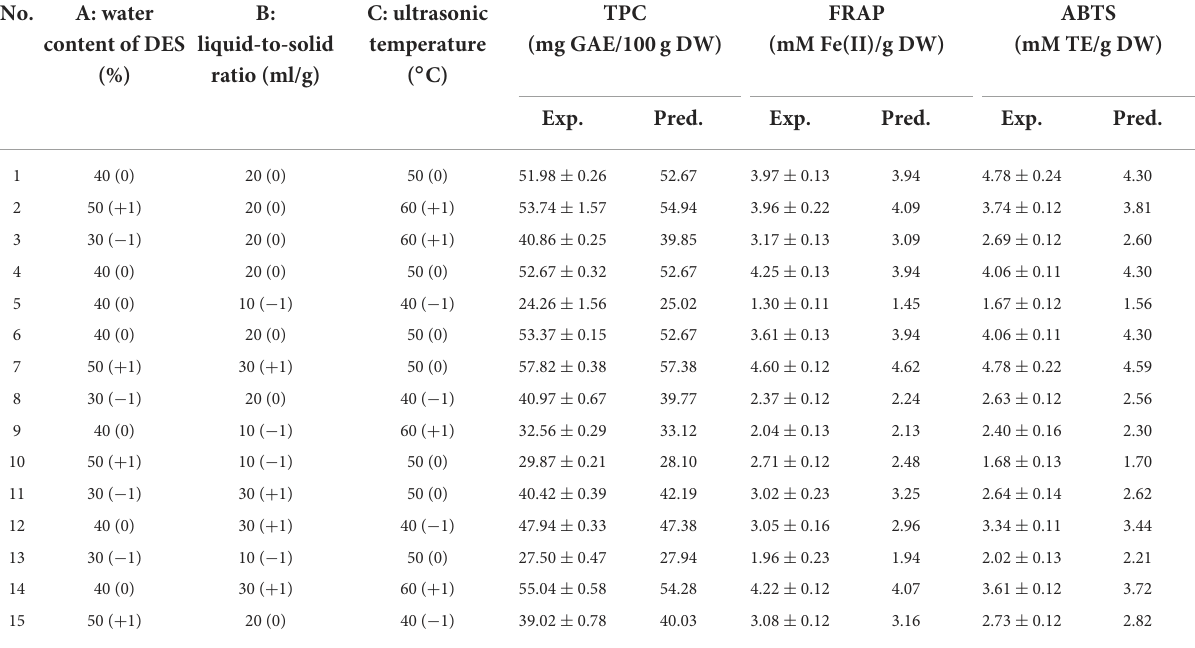
TABLE 2 Box-Behnken design and experimental